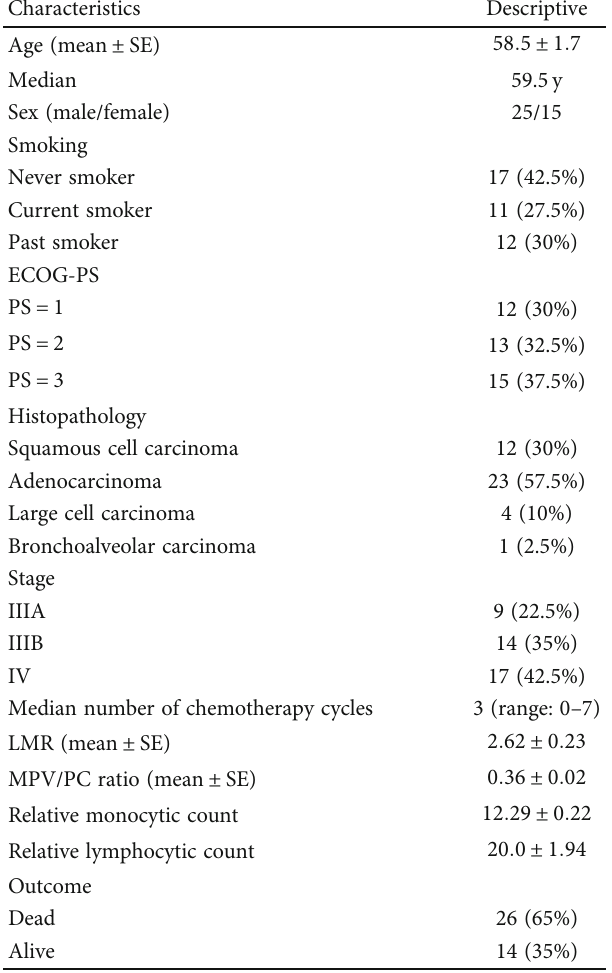
Table 2: Clinicopathologic characteristics of 40 patients with NSCLC.